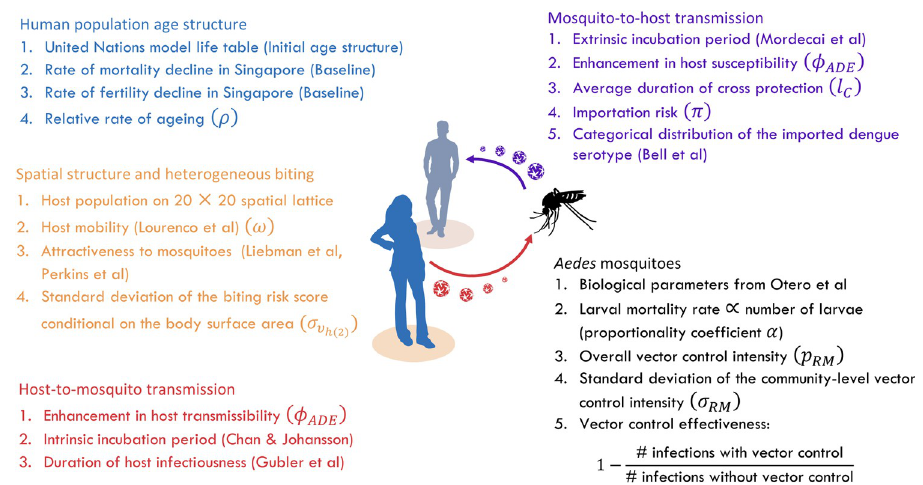
Fig 1. Schematic overview of the individual-based